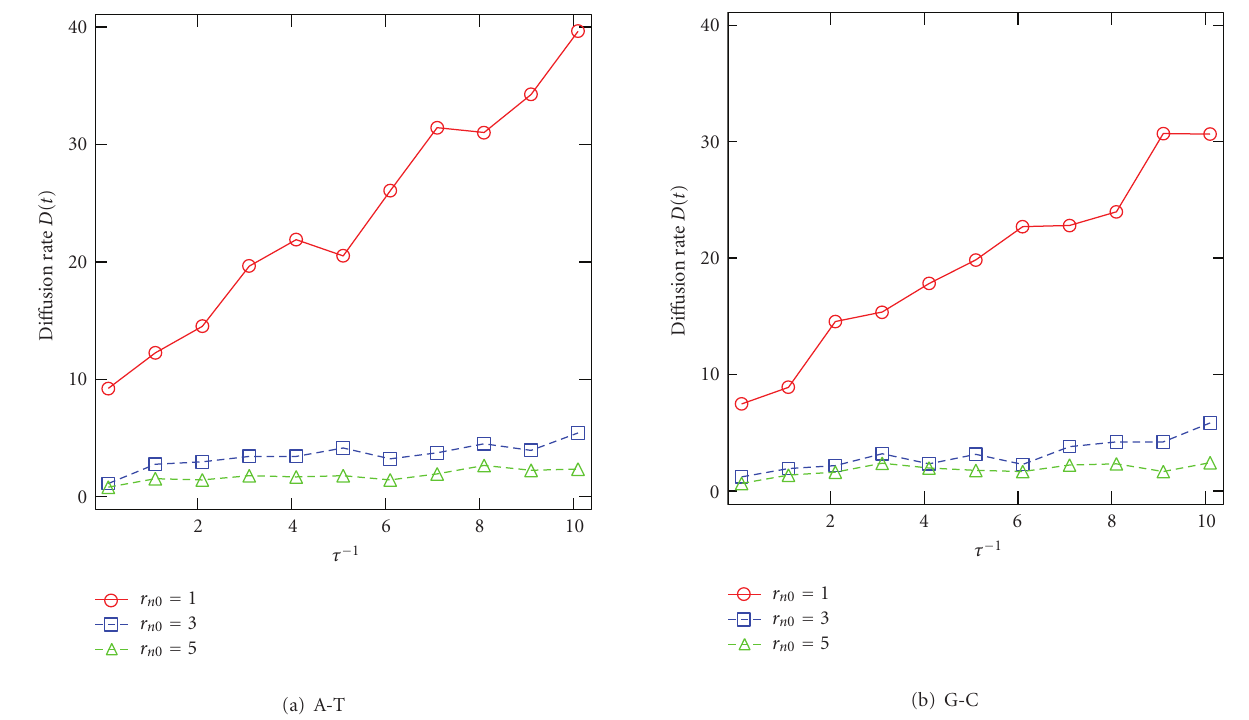
Figure 7: Di ff usion rate D ( t ) as a function of τ − 1 for several fluctuation strengths r n 0 = 1,3,5 at (a) A-T model and (b) G-C model, respectively.